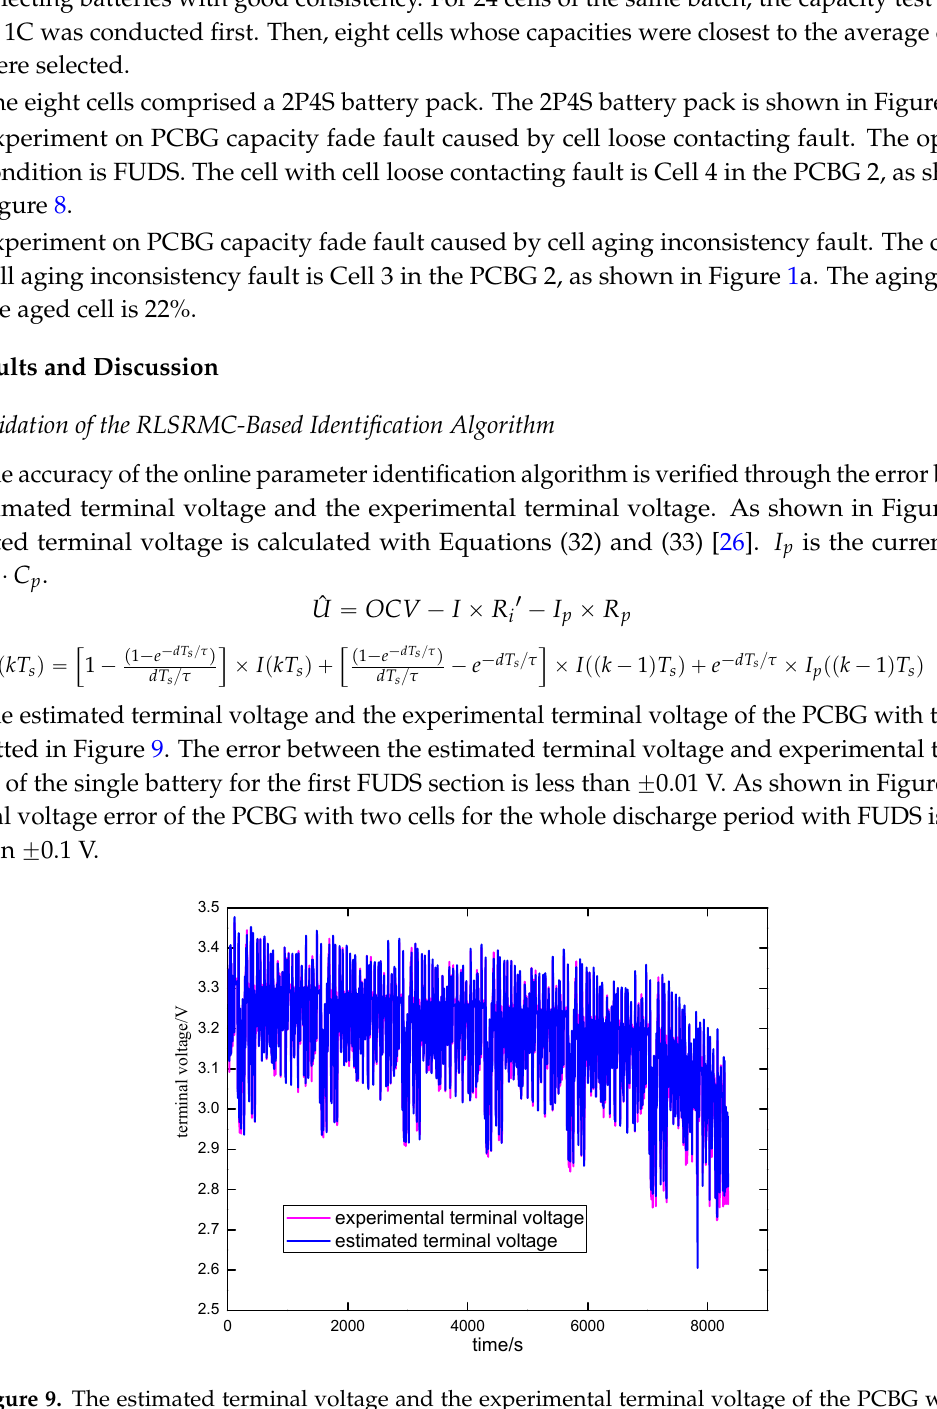
Figure 10. The error between the estimated terminal voltage and experimental terminal voltage of the PCBG with two cells. 4.2. Validation of Online Fault Diagnostic Algorithm 4.2.1. Simulation Result Analysis As shown in Figure 7, cell resistance increase fault and cell aging inconsistency fault are both simulated with FUDS. On the basis of the simulation data, the parameters of the PCBGs are identified by RLSRMC algorithm. The identified PCBG resistances of the PCBGs are shown in Figures 11 and 12. In Figure 11, the curves 1#, 2# and 3# denote the PCBGs with the cell resistance increased to 1000%, 500% and 150% of the normal cell resistance respectively. In Figure 12, curves 1#, 2# and 3# denote the PCBGs including cells with aging state of 51%, 22% and 10% respectively. The PCBG resistance of the healthy PCBG does not change, which is shown as curve 4# in Figures 11 and 12. Figures 11 and 12 show